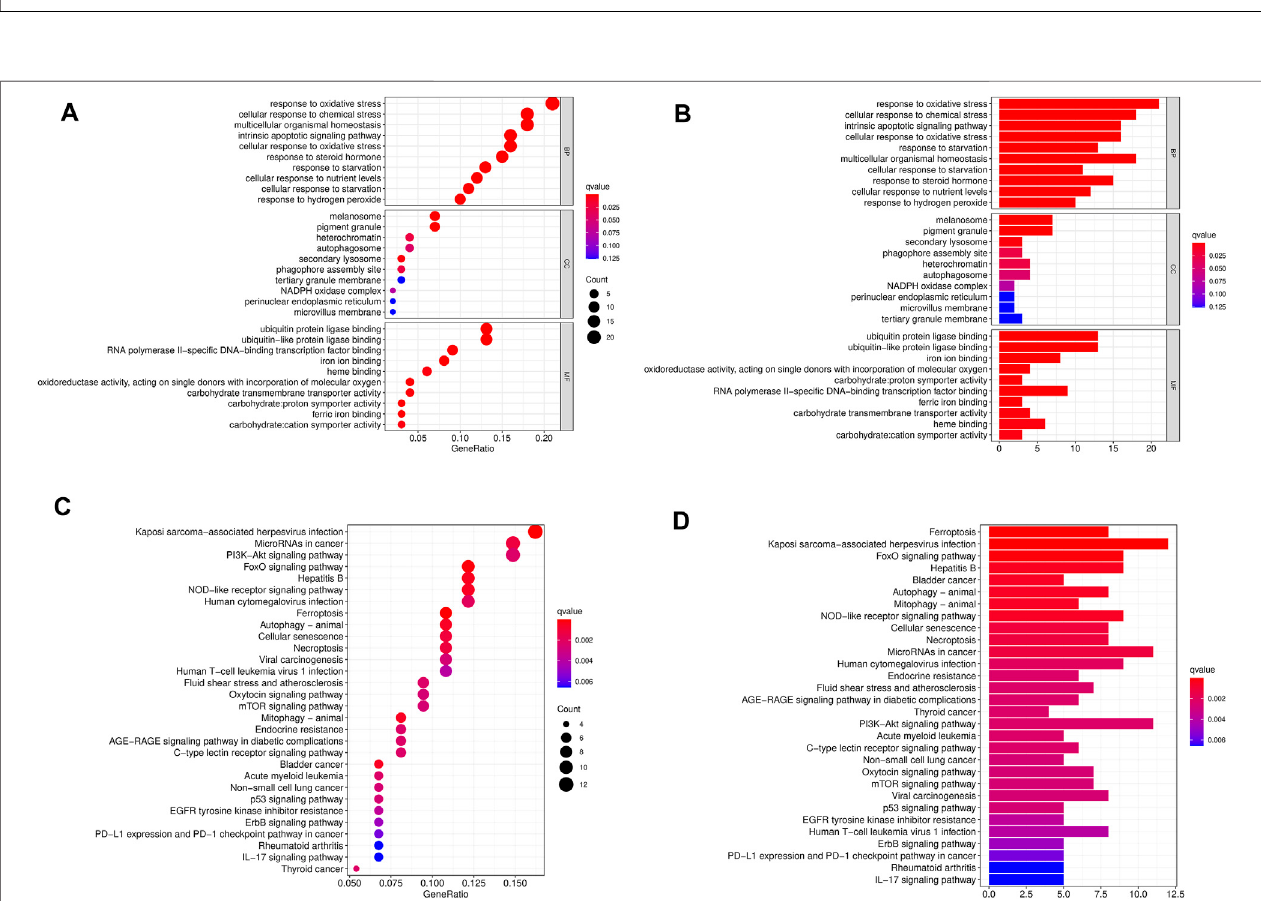
FIGURE2| GOandKEGGenrichmentpathwaysofdifferentiallyexpressedferroptosis-relatedgenes.Thedotgraph (A) andbargraph (B) ofGOandthedotgraph (C) and bar graph (D) of KEGG are shown. The size of the dot indicates the count, and the color indicates the Q value.